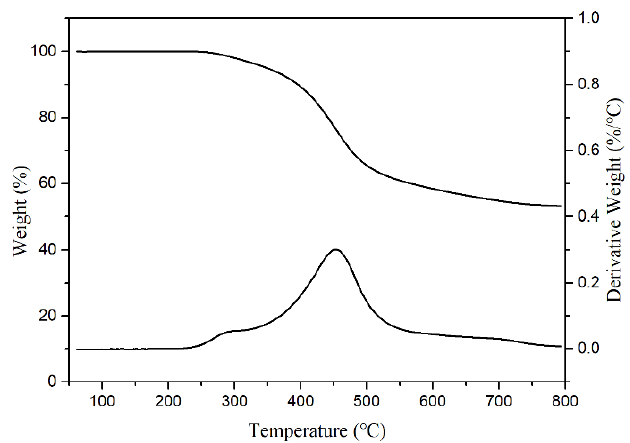
Figure 6. TGA curves for p(T–Fa) under nitrogen.